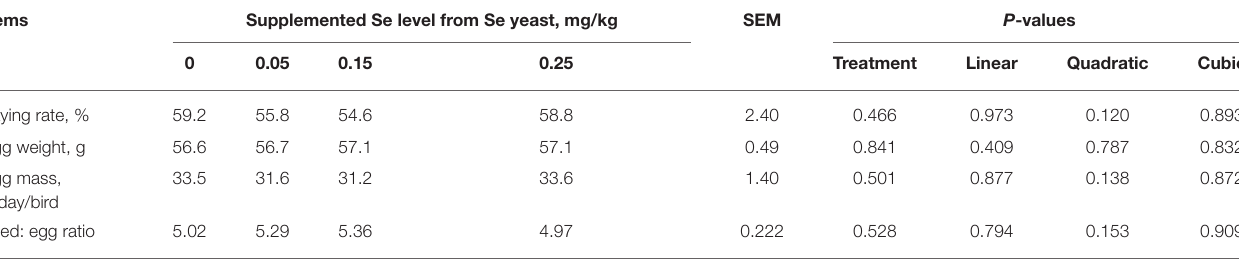
TABLE 2 | Effect of dietary Se yeast supplementation on the laying performance of Longyan laying ducks ( n = 6) a . Items Supplemented Se level from Se yeast, mg/kg SEM P -values